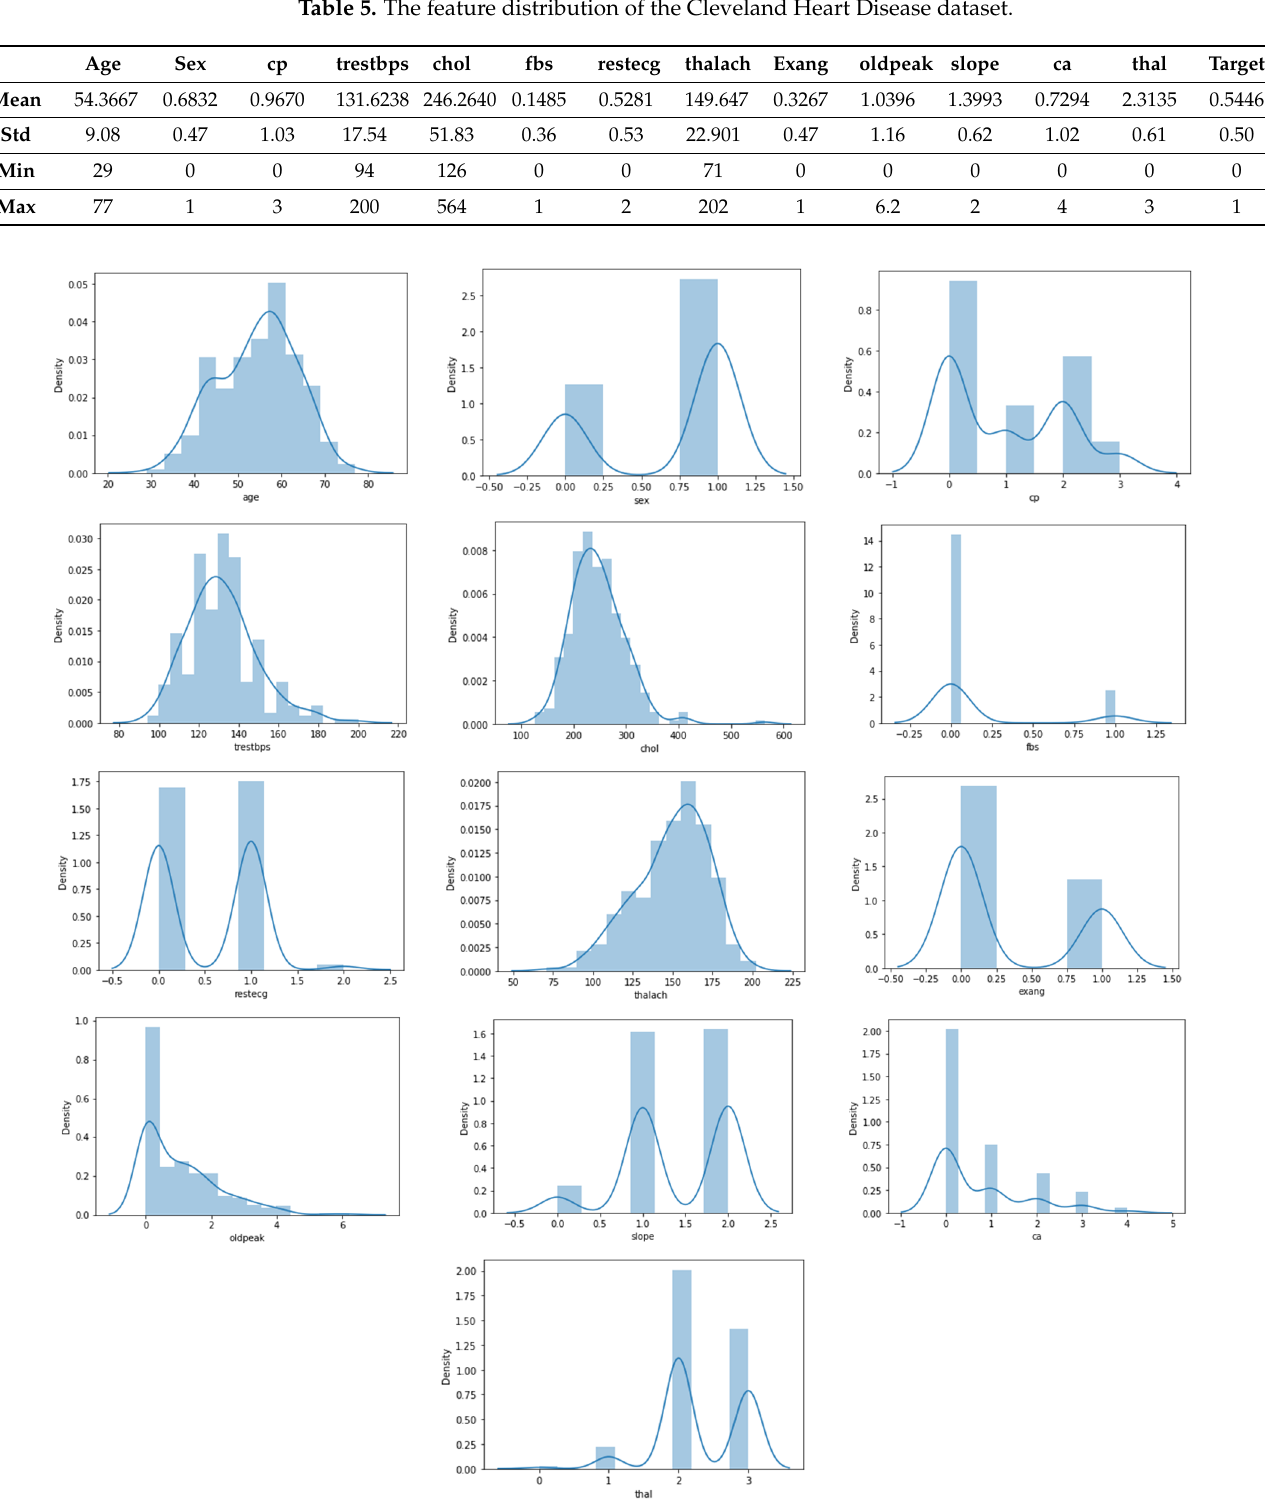
Figure 3. Statistical description of heart disease dataset.